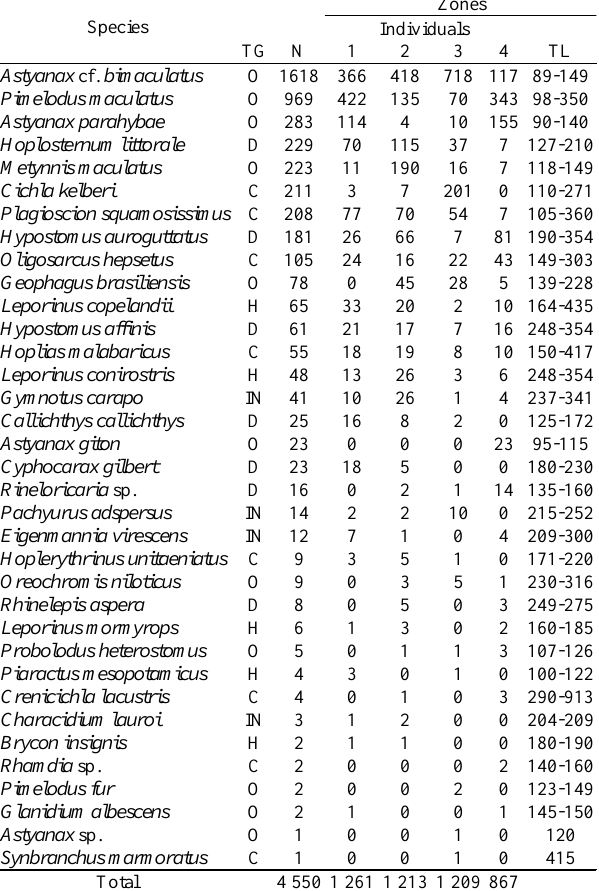
Table 1. Total number of individuals (N), trophic guilds (TG) and total length (TL in mm) range of fish species by zone (1, 2, 3, 4) in the Paraíba do Sul River - Funil Reservoir system. O = omnivores;